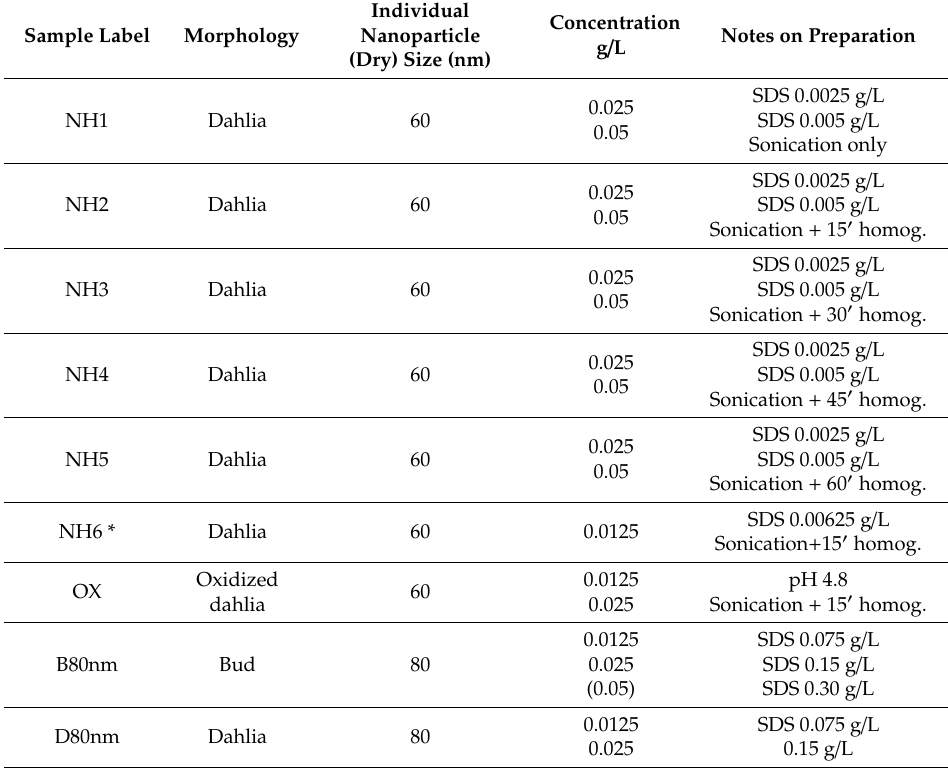
Table 1. Investigated samples. All nanofluids, except oxidation (OX) ones, are prepared with not-functionalized (pristine) single-walled carbon nanohorns (SWCNHs). * Same protocol as NH2, prepared again for comparison with the OX sample at equal sample